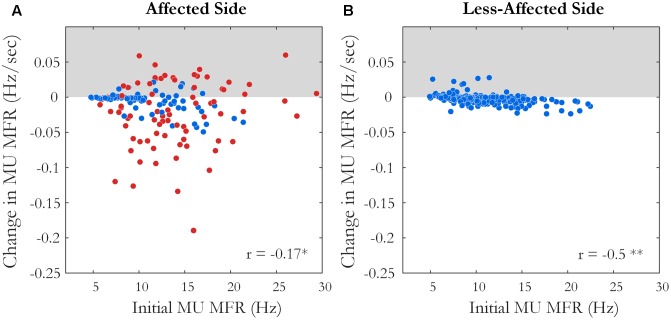
The slope and intercept of the linear fit to the change in MU MFR over the course of the sustained fatiguing contraction over all subjects on (A) the affected side, ∗p < 0.05 and (B) the less-affected side, ∗∗p < 0.01. Each data point represents an accepted MU; red points indicate MUs from the affected side of subjects with an endurance time for the fatigue task <75% of the shortest time to task failure on the less-affected side.